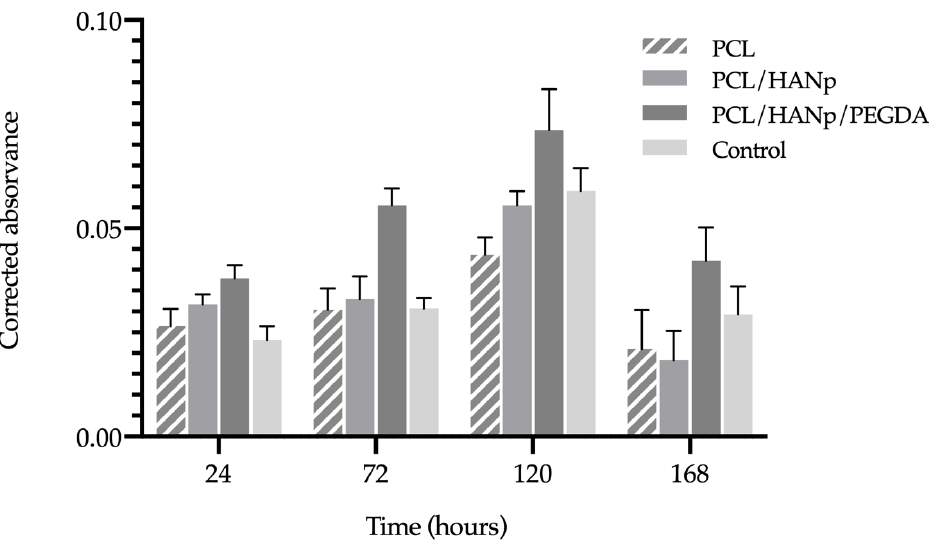
Figure 9. Corrected absorbance evaluated by PrestoBlue ® viability assay for hDPSCs after 24, 72, 120 and 168 h.